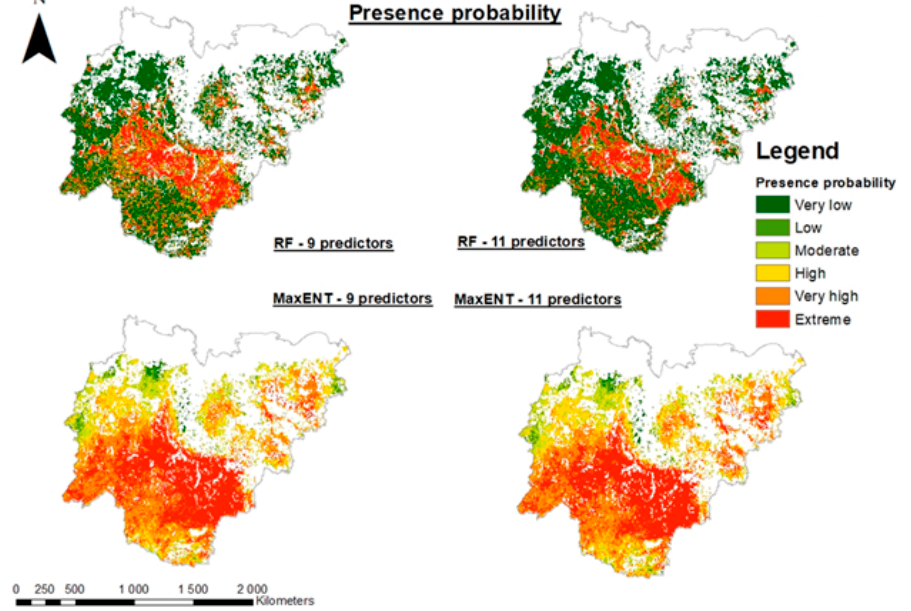
Figure 4. Results of the long-term wildfire presence probability in Yakutia (macroscale).